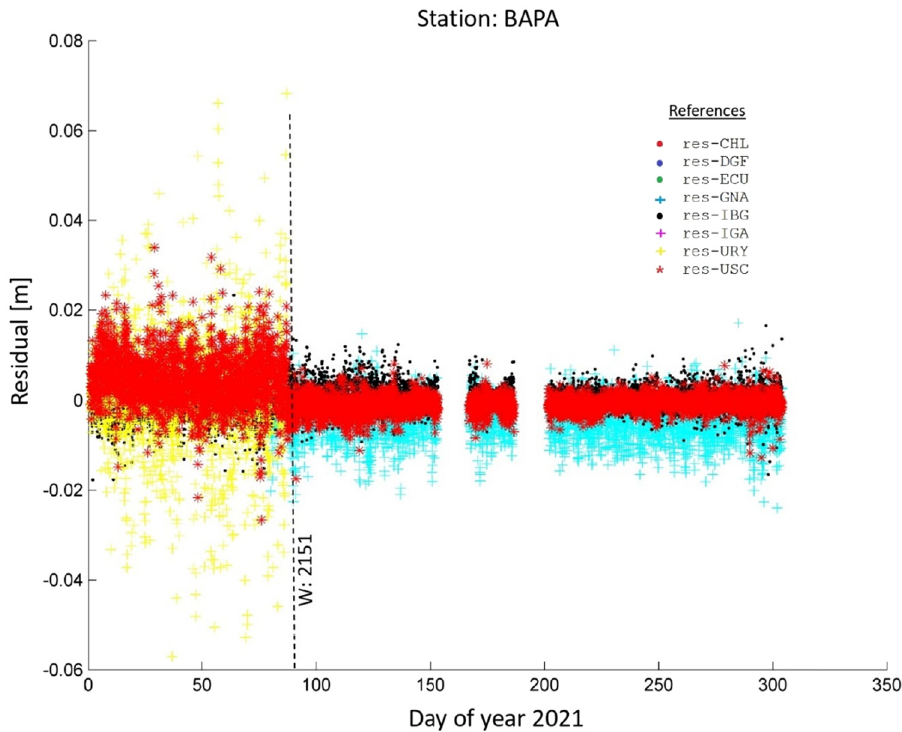
residuals in BAPA, SIRGAS - CON Station, day of year 2021. Figure 7: ZTD i tj